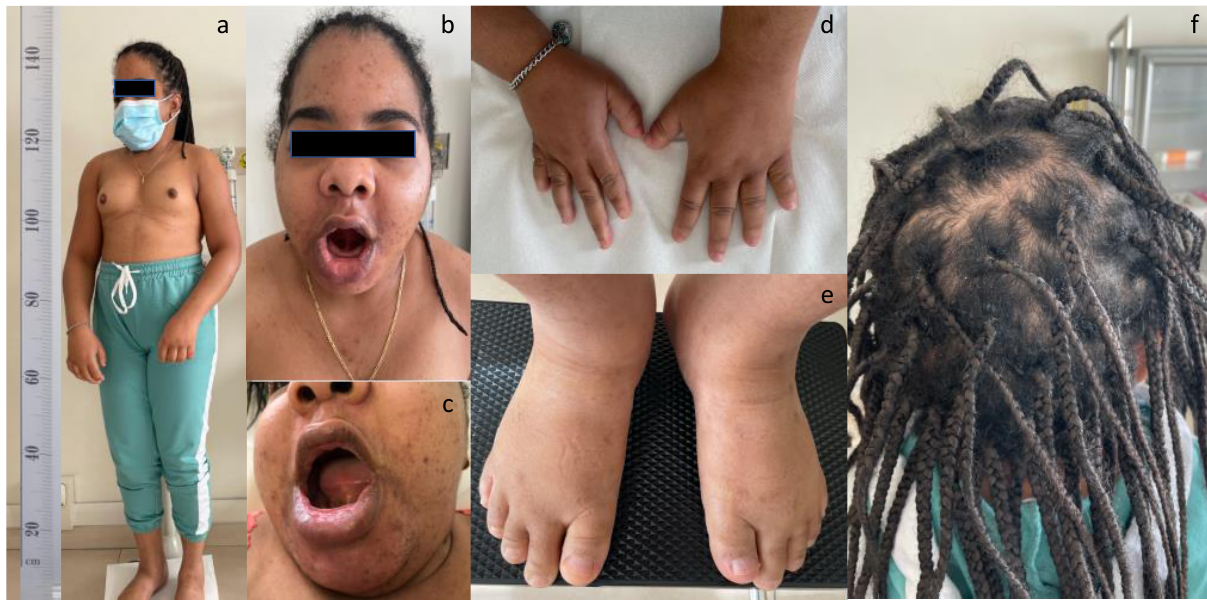
Figure 1. ( a ) Clinical characteristics of the patient with short stature. Closeup of the face ( b ) of the mouth ( c ), of the hands ( d ), of the feet ( e ) and of the hair ( f ). She was short-statured (height 143 cm) and overweight (weight 59.0 kg, BMI = 28.9 kg/m 2 ), with a round face, a short neck, a broad chest and obese abdomen (Figure 1, panels a, b). Physical examination of the hands indicated a type E brachydactyly, that affected the 4th and 5th fingers more, and a type D brachydactyly (Figure 1, panel d). She had a positive knuckle sign (Archibald’s sign), consisting in the appearance of a dimple at the position of bone (Figure 1, panel e). Examination of the mouth showed that the upper lip was larger than normal and the lower lip was prominent (Figure 1, panel c). Intraoral examination revealed complete anodontia, broad, flat alveolar ridges, and shallow vestibules. The mucosa over the ridges was pale and atrophic with smooth, globular elevations along the persistent patchy alopecia areata that the patient was masquerading with hair extensions (Figure 1, panel f). An ultrasonographic examination of the thyroid gland and of the parathyroid did not show any alteration, and both sonography and Rx mammography of the breast revealed the presence of bilateral subcutaneous calcifications (data not